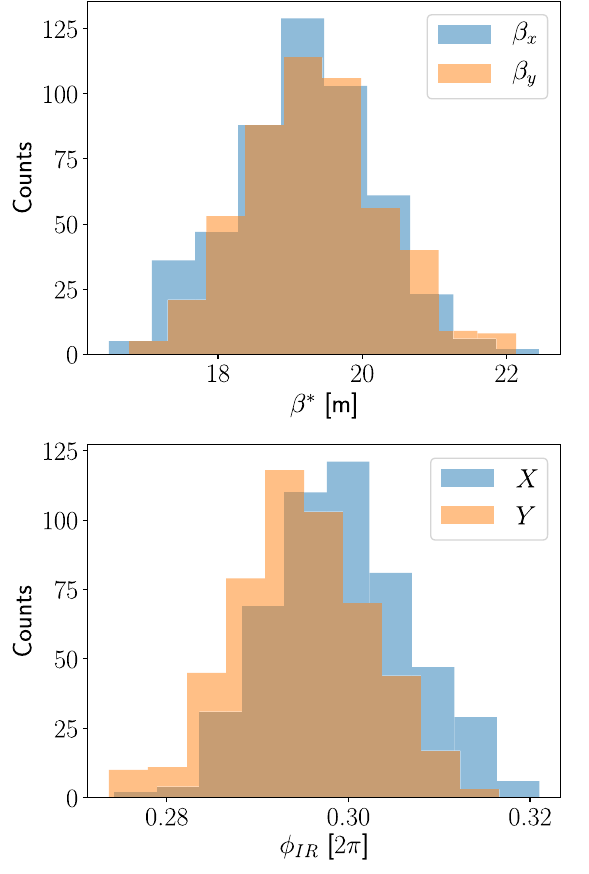
FIG. 6. Histograms for β (cid:1) beating and ϕ model after introducing magnetic errors in the quadrupoles for IP1 before K modulation is applied.